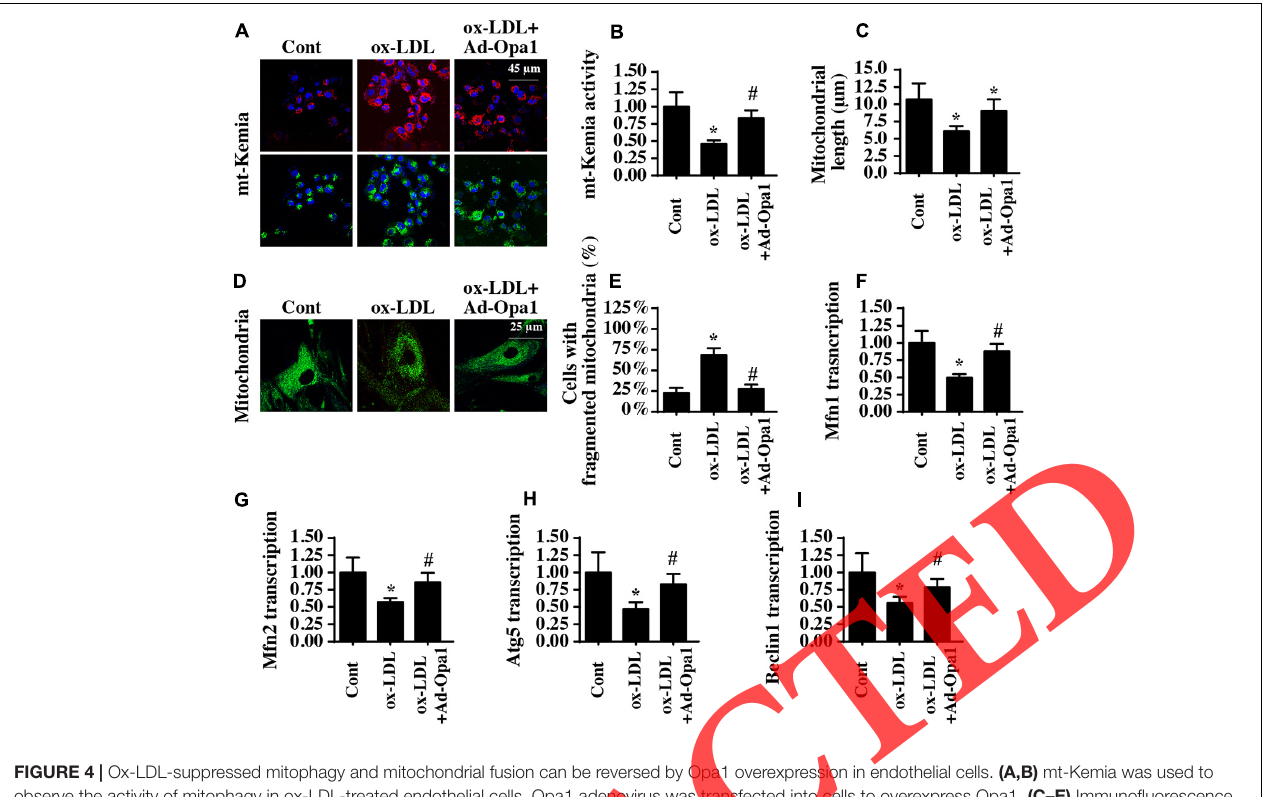
FIGURE 4 | Ox-LDL-suppressed mitophagy and mitochondrial fusion can be reversed by Opa1 overexpression in endothelial cells. (A,B) mt-Kemia was used to observe the activity of mitophagy in ox-LDL-treated endothelial cells. Opa1 adenovirus was transfected into cells to overexpress Opa1. (C–E) Immunofluorescence of mitochondria morphology. The average length of mitochondria was determined. Opa1 adenovirus was transfected into cells to overexpress Opa1. (F–I) RNA was isolated from endothelial cells and the transcription of Mfn1, Mfn2, Atg5, and Beclin1 were determined through qPCR. * p <